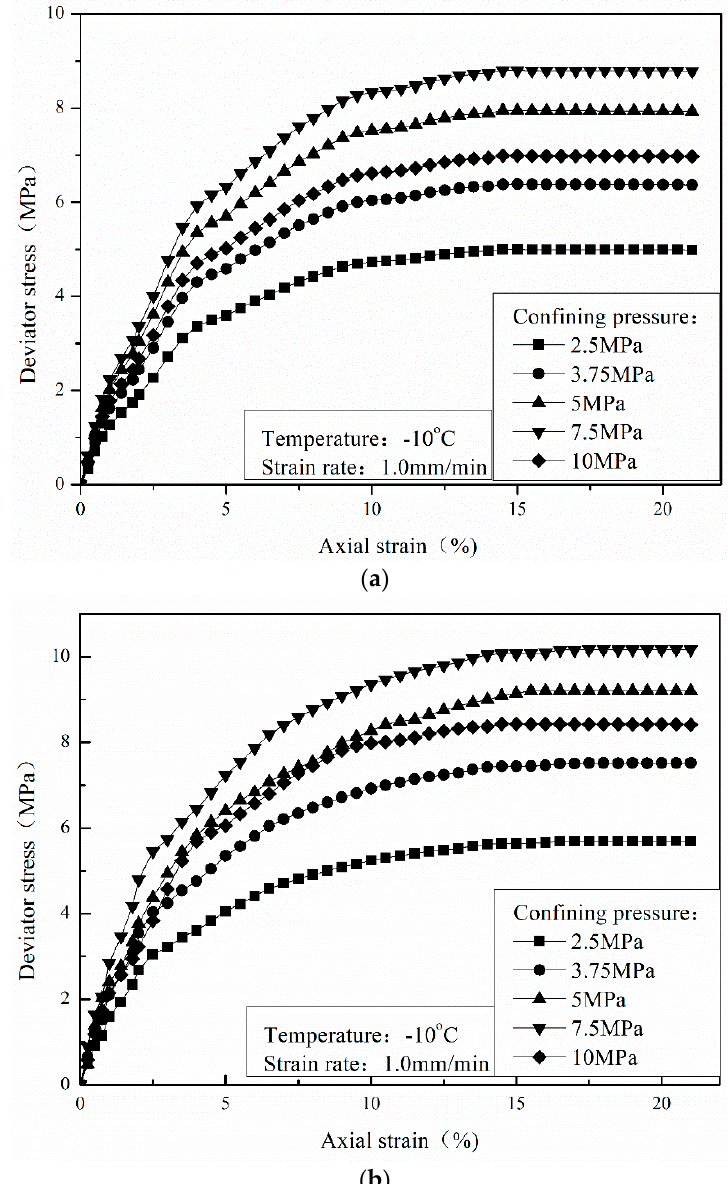
Figure 8. Stress-strain curves of the CH 4 and CO 2 hydrate-bearing sediments under different confining pressures. ( a ) CH 4 hydrate-bearing sediments; ( b ) CO 2 hydrate-bearing sediments.